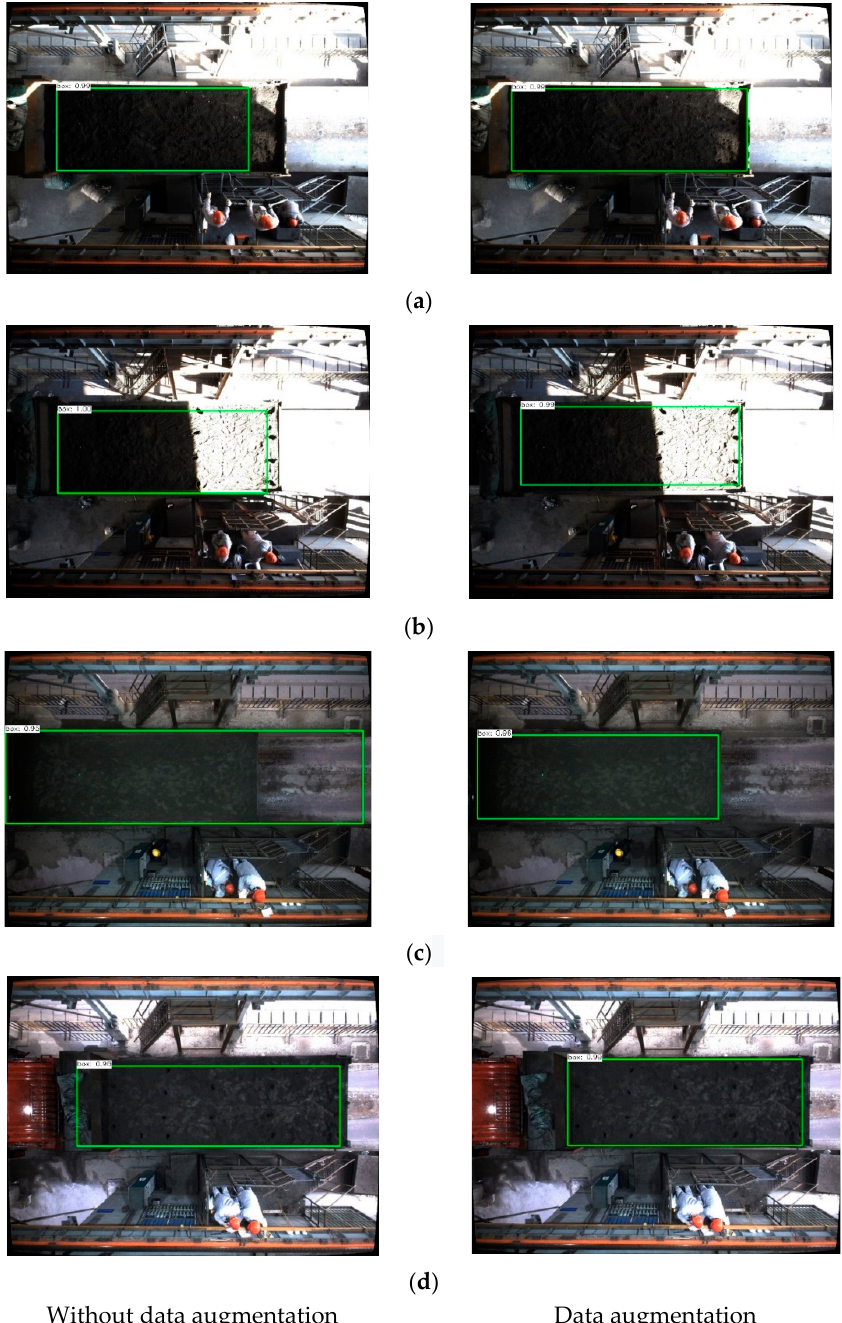
Figure 15. Graphs of detection results in test sets of different scenarios. ( a ) Small part of the lighting scenes. ( b ) Most lighting scenes. ( c ) Cloudy scenes. ( d ) Night lighting scenes.